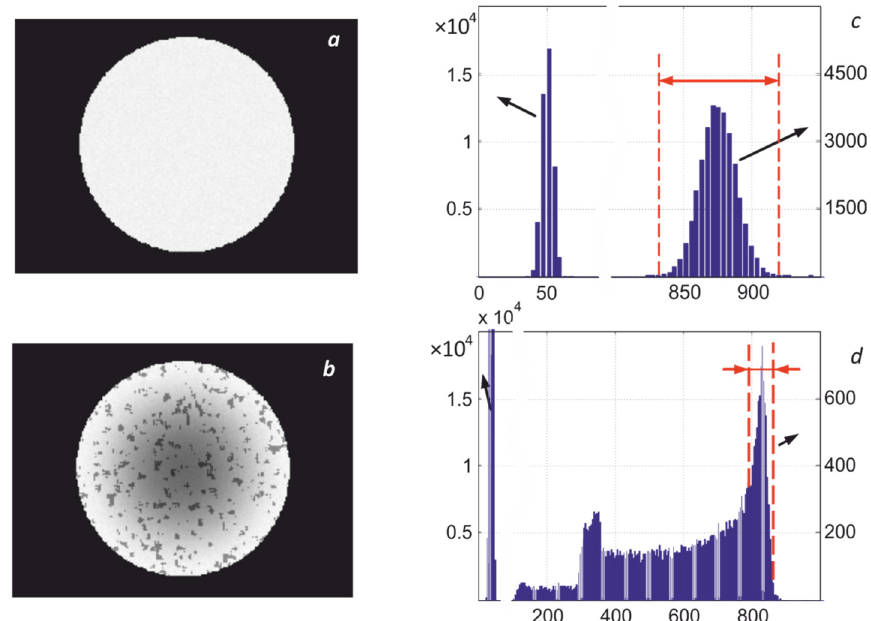
Figure 14. Examples of thermal images with uniform ( a ) and non-uniform ( b ) temperature distribution over the surface and their corresponding histograms ( c , d ).